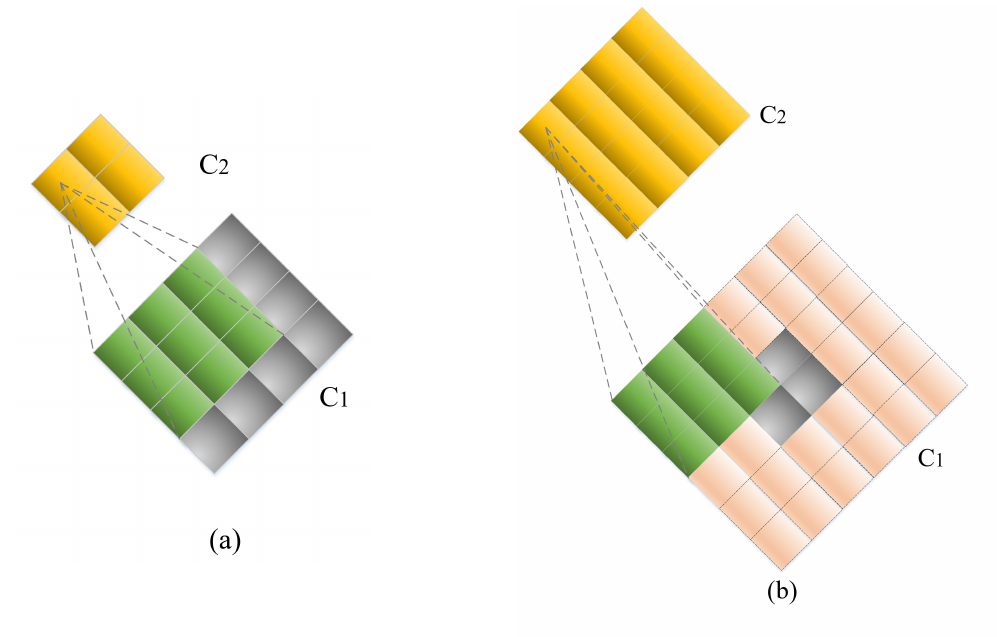
Figure 6. Demonstration between two-dimensional operations of ( a ) deconvolution operation and ( b ) deconvolution